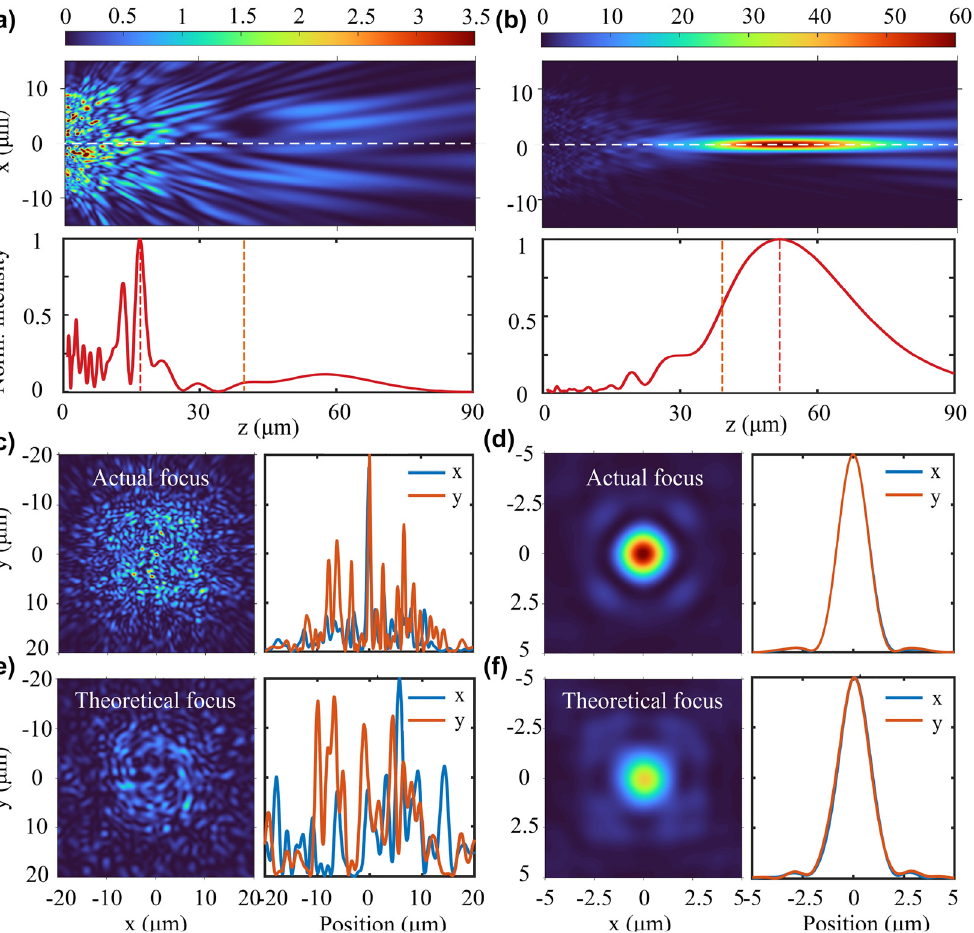
Figure 4: Intensity distributions for the initial random (left columns) and topology-shape optimized (right columns) structures. (aandb)intensitydistributionsalongthe z -direction.Theorangeandreddashedlinesindicatethepositionsofthetheoreticalandactualfocal points, respectively. The white dashed line indicates the cross-section of normalized intensity. (c – f) intensity distributions at the actual and theoretical focal